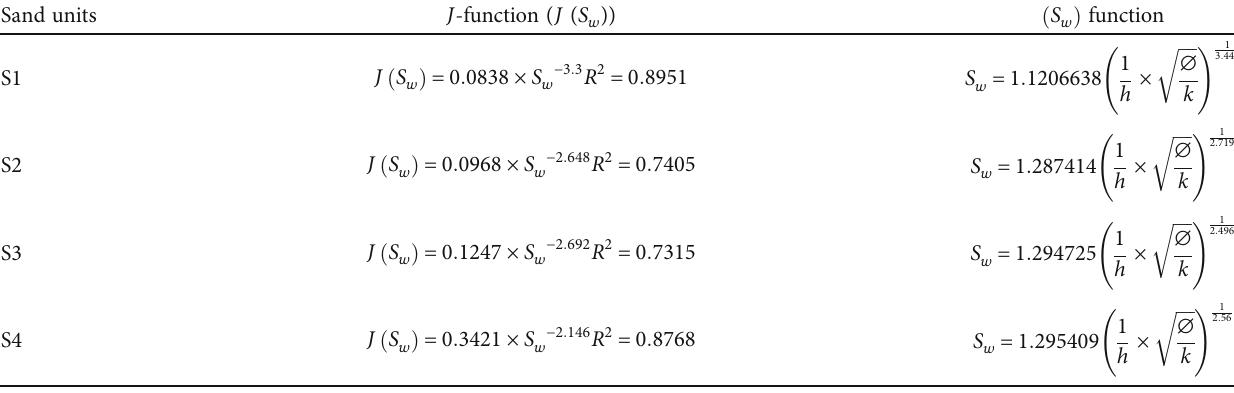
Þ and J ( S ) function of (S1 ~ S4) sand units. w w